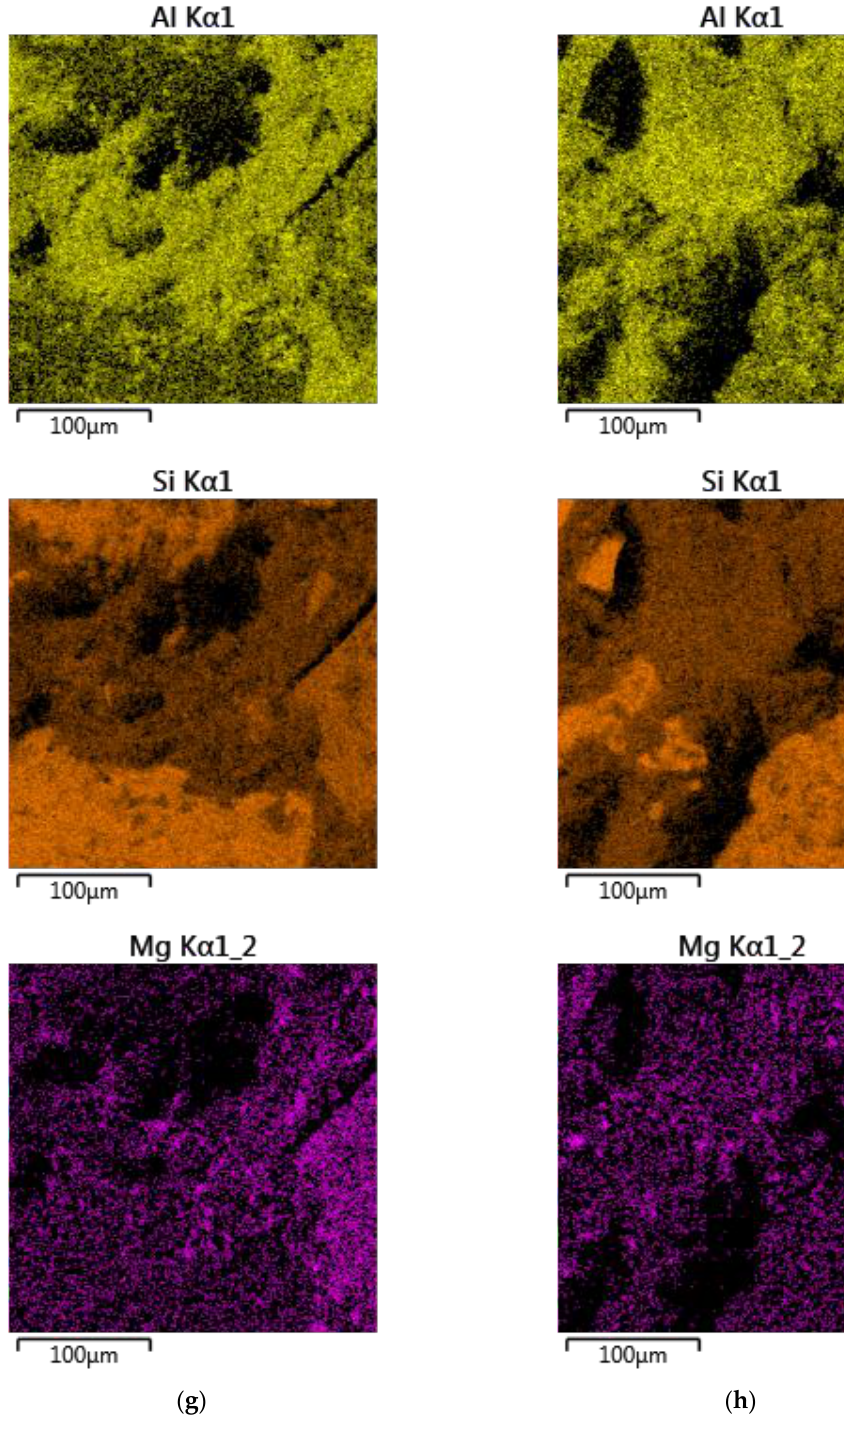
Figure 18. SEM images: ( a ) BSE, M.6.0, mag.: 100×; ( b ) BSE, M.6.1, mag.: 100×; ( c ) map of Si distribution, M.6.0, mag.: 100×; ( d ) map of Si distribution, M.6.1, mag.: 100×; ( e ) BSE, M.6.0, mag.: 1kx; ( f ) BSE, M.6.1, mag.: 1k×; ( g ) maps of elements distribution, M.6.0, mag.: 1k×; ( h ) maps of elements distribution, M.6.1, mag.: 1k×.